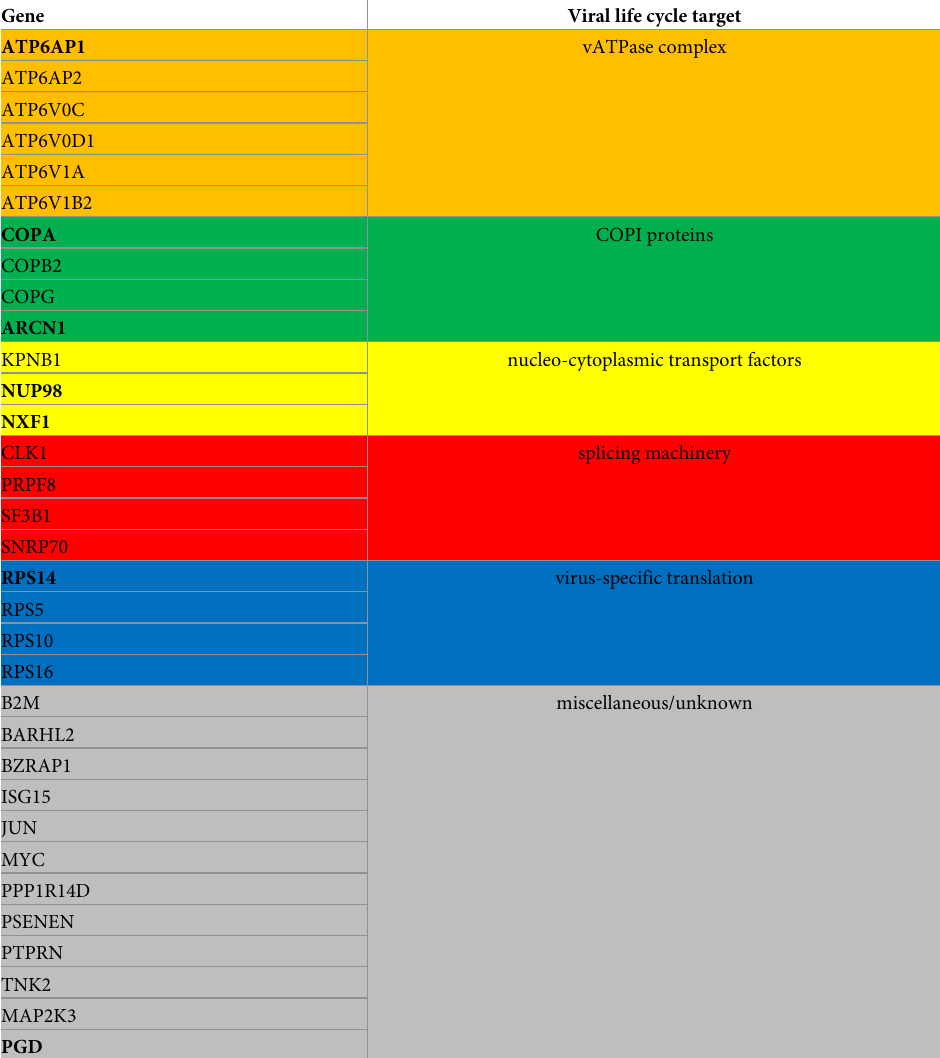
Table 1. Candidate genes for knockdown (those targeted in this study are in